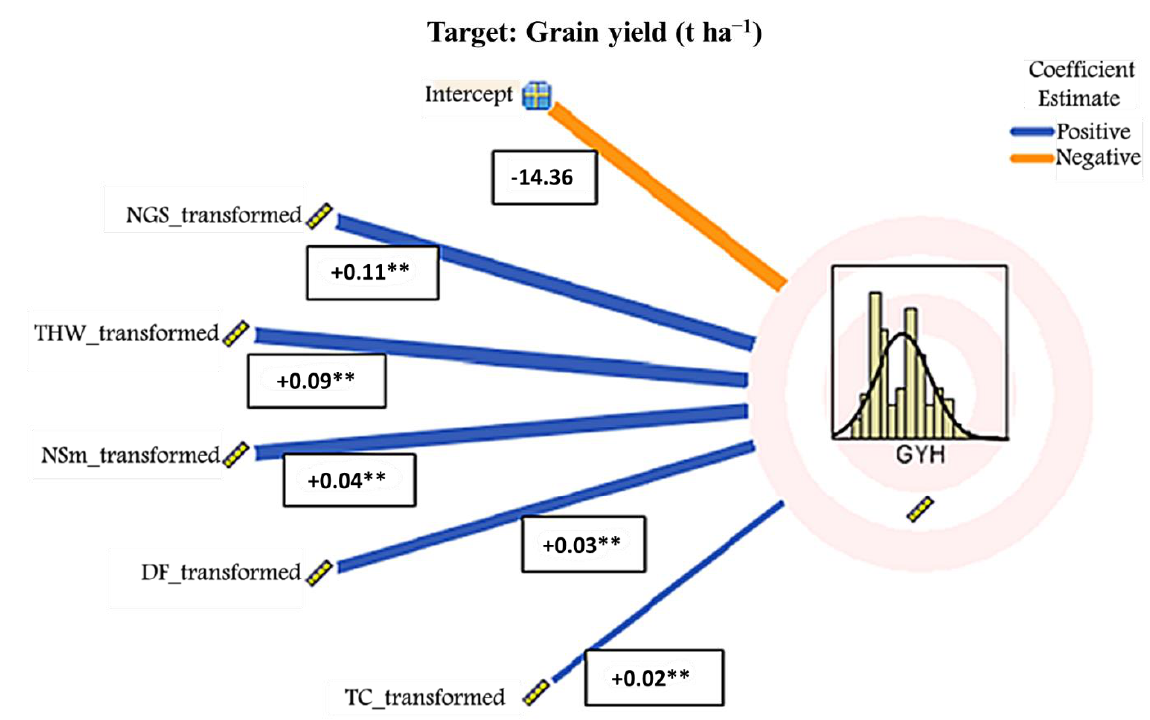
Figure 4. Automatic linear regression for predicting grain yield ha − 1 and its attributes overall factors (combined of two successive seasons, 2017–2018 and 2018–2019). Where: GYH = grain yield ha − 1 ; THW = 1000-grain weight; NGS = number of grains/spike; NT = number of fertile tillers; NSm = number of spike m − 2 ; DF = days to 50 heading; TC = total chlorophyll content (SPAD) and ** indicate significant at 0.01.